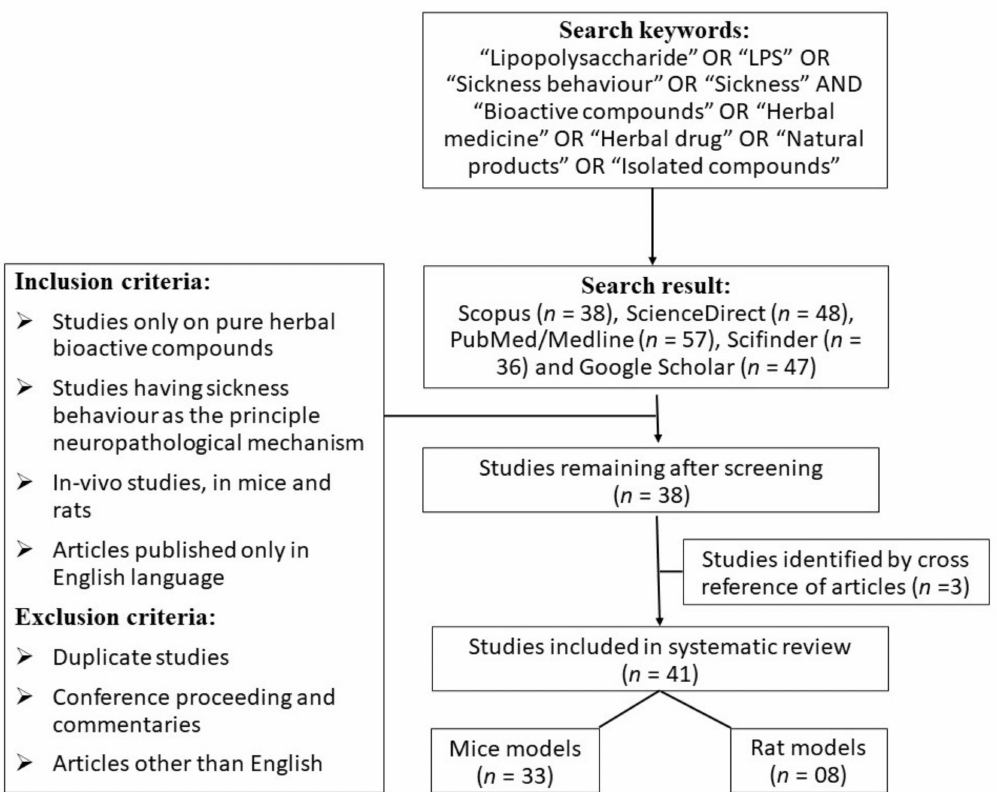
Figure 4. Search